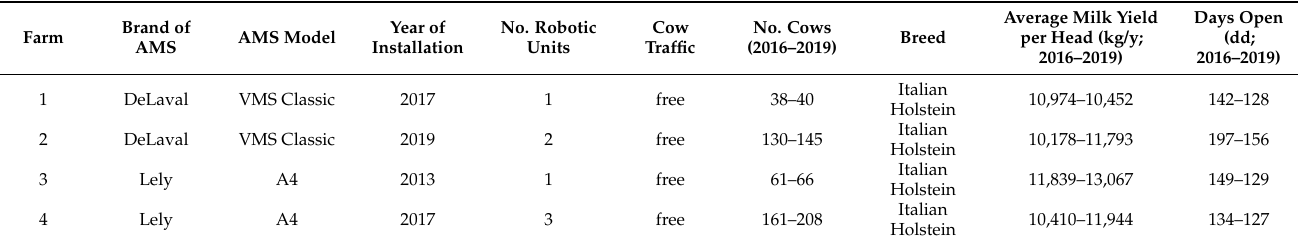
Table 1. Main farm characteristics (no. cows, milk yield, and days open are obtained from the report of the official controls of the National Breeders’ Association for years 2016 and 2019, respectively).